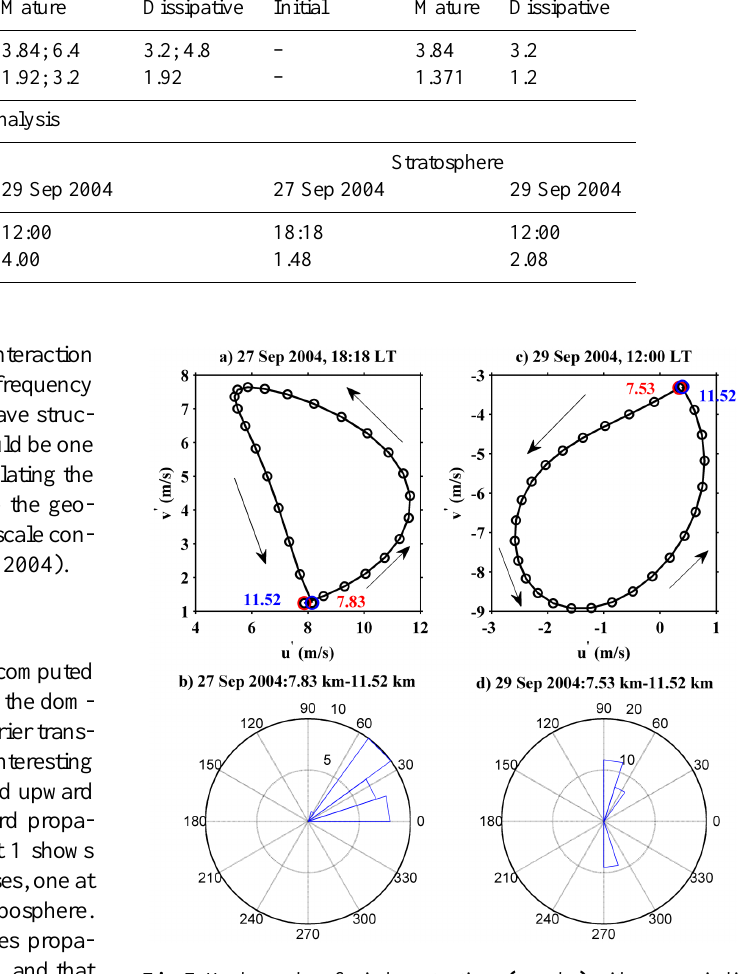
Fig. 7. Hodographs of wind fluctuations (a and c) with arrows indicating direction of rotation and corresponding horizontal direction of propagation (b and d) of the gravity waves. They are plotted for every 30 ◦ of 27 September 2004 and 29 September 2004 after about 1h of cessation of convection in the tropospheric region (4–15km). Values 0 ◦ , 90 ◦ , 180 ◦ , and 270 ◦ are assigned as the eastward, northward, westward, and southward directions, respectively. segments) for 27 September 2004 16:30 LT (black), 17:30 LT (black dashed) and 18:30 LT (gray) and mature and dissipa- tive phases of convection for 29 September 2004 09:00 LT (black) and 10:00 LT (gray). Vertical wavelengths of GWs are tabulated for different phases of convection in Table